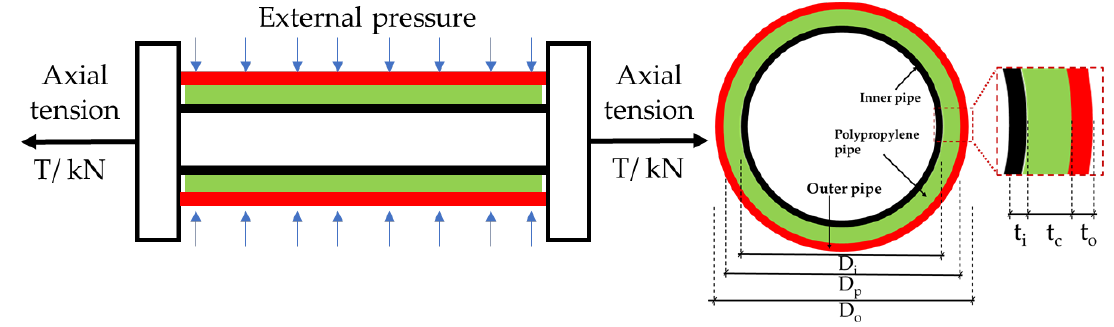
Figure 1. Geometry of tubes and idealized loading adopted in experiment.